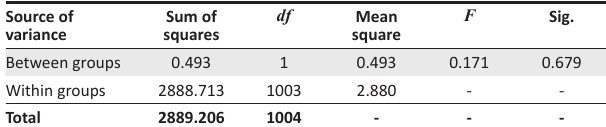
TABLE 3: ANOVA: differences between leadership effectiveness means across race. Source of Sum of variance squares